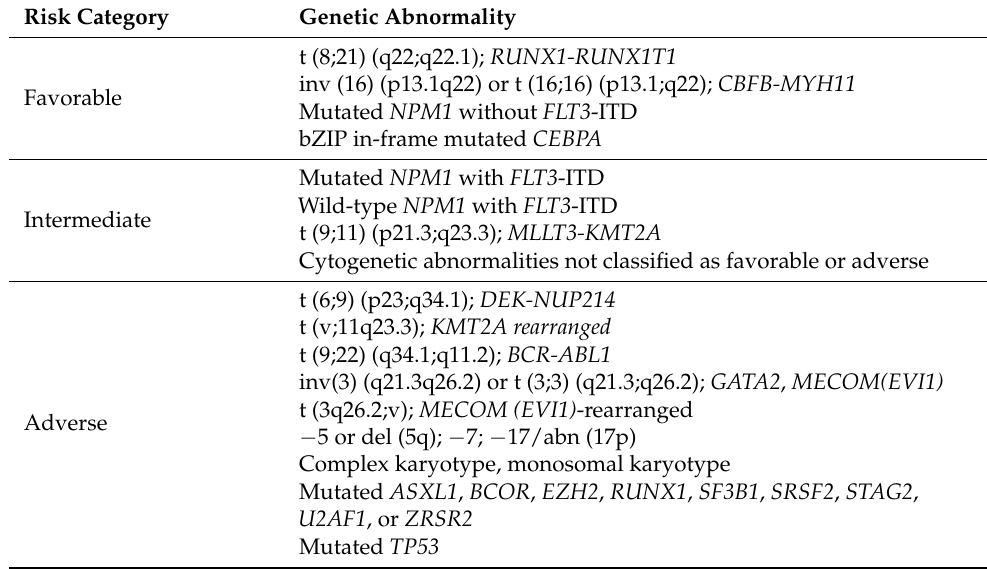
Table 1. ELN 2022 Risk Stratification